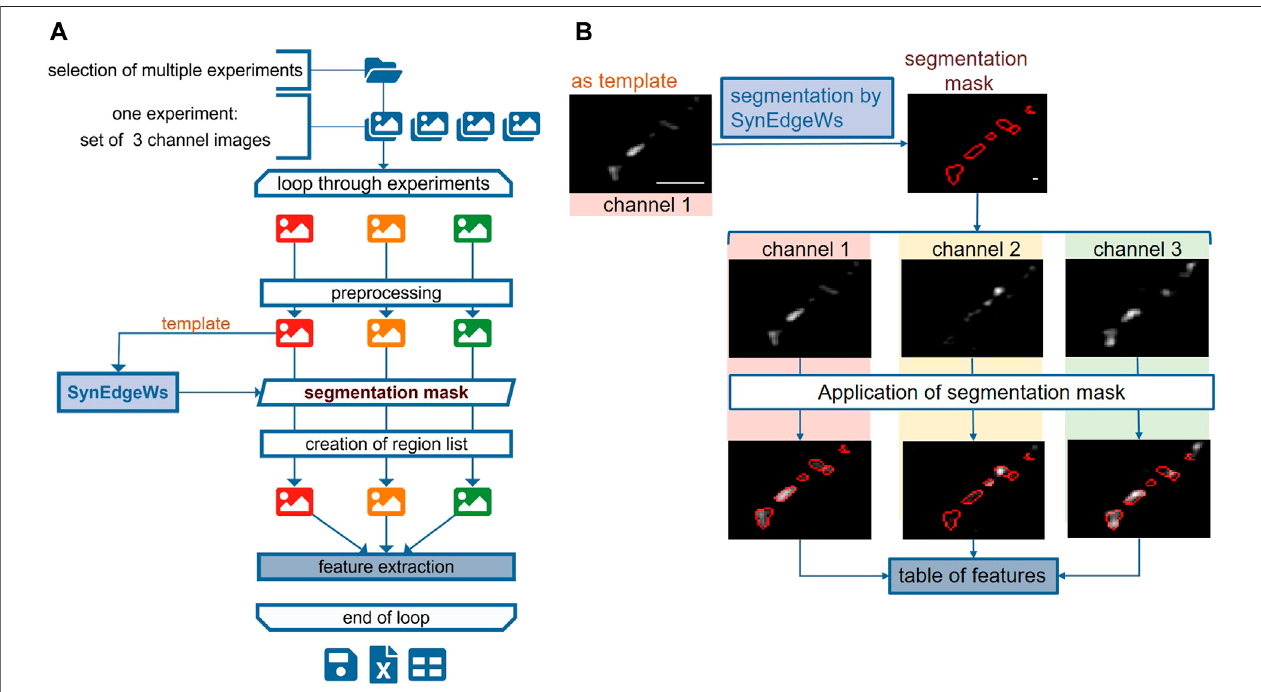
FIGURE 2 | SynEval for detection and analysis ofsynapses in three-channel immuno fl uorescent images. The schema in (A) shows all steps of SynEval routine. (B) Image recorded in channel 1 (here Syn1,2 staining) serves as a template to create segmentation mask. The segmentation mask is applied on images from channels 2 (Syt1Ab uptake) and 3 (anti-VGAT staining) to read out parameters and create table of features. Scale bar is 4